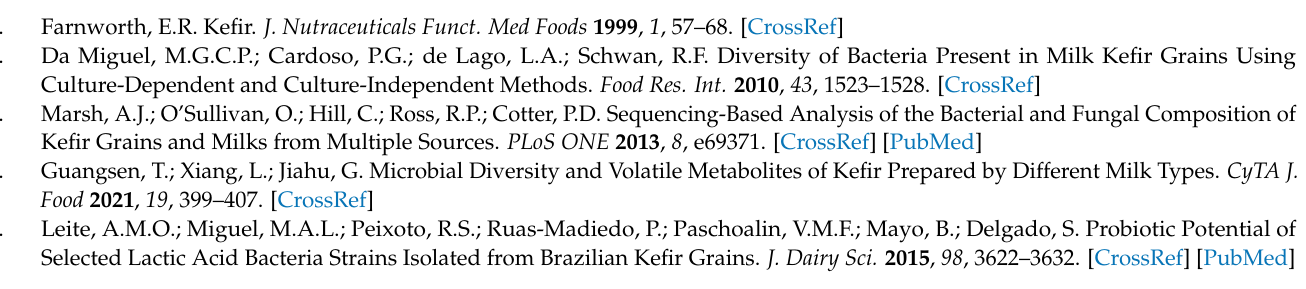
Figure S3: Metabolism of proteins in kefir beverages. Figure S4: Metabolism of carbohydrates in kefir beverages. Figure S5: Virulence, Disease and Defense genes in kefir beverages, Figure S6: Cellulose in kefir beverages. Table S1: Composition of non-commercial culture media. Table S2: Sequence statistics for metagenomic sequencing of 16S rDNA. Table S3: Sequence statistics for shotgun metagenomic sequencing kefir